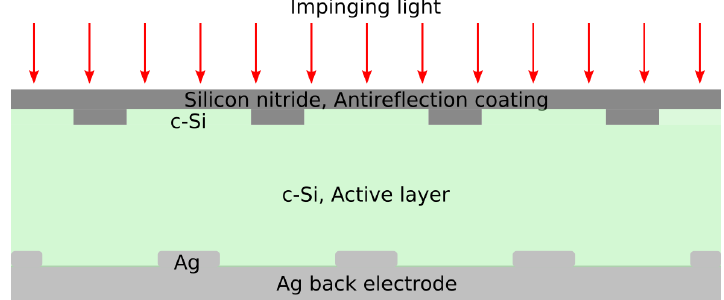
Figure 1. schematic of the solar cell